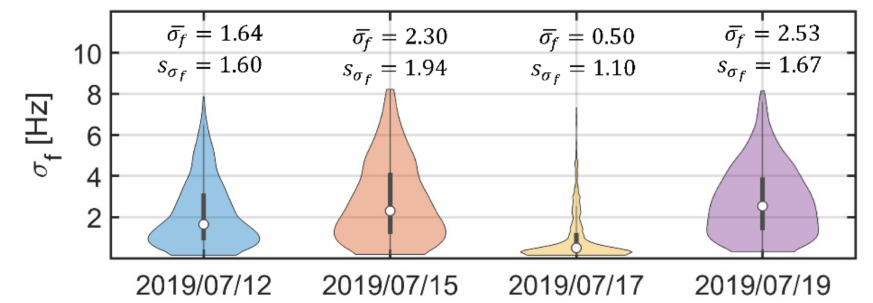
Figure 8. Doppler spread distribution for each flight day. Mean values of the Doppler spread σ f and the standard deviation s σ are shown above each violin plot for each day. The mean value of the f highest sea-state day is 2.53 Hz, while the lowest sea state represents a mean value of 0.5